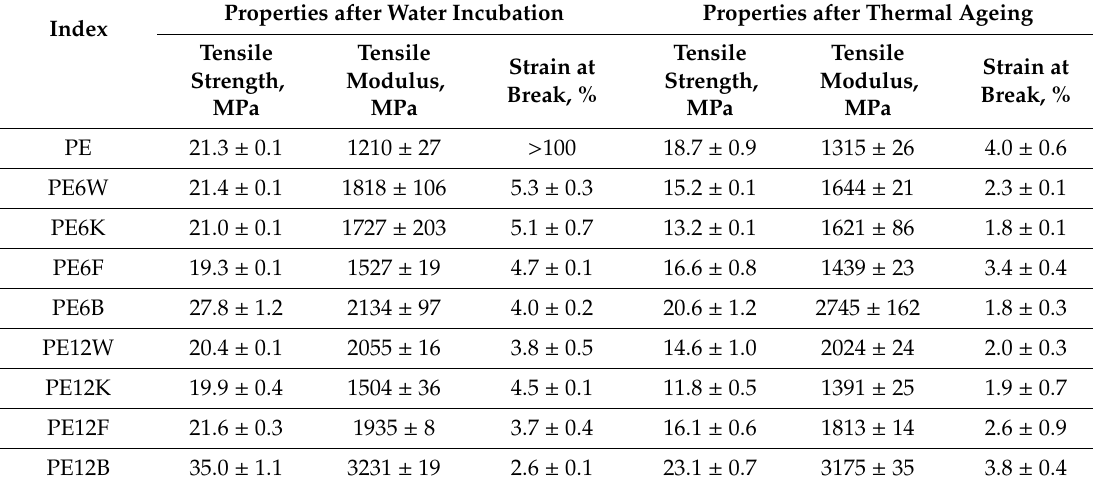
Table 5. Mechanical properties measured after water and thermal